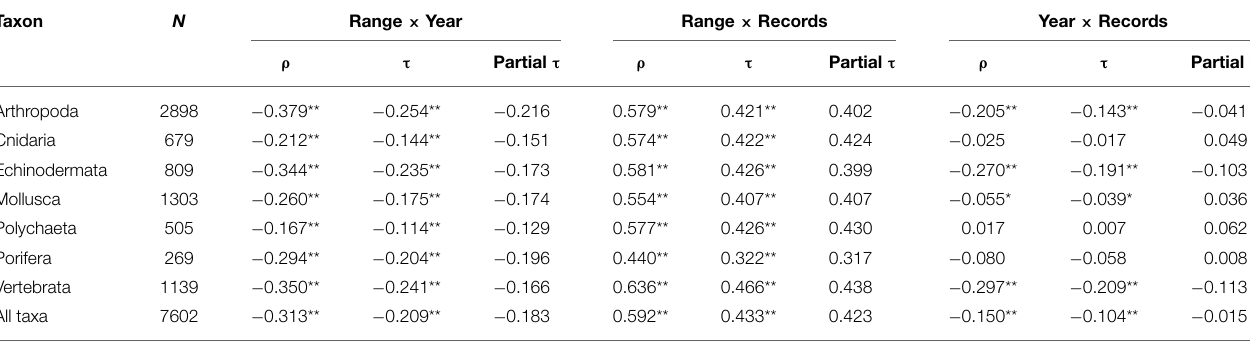
Correlations marked as significant at 5% ( * ) and 1% ( ** ) levels.